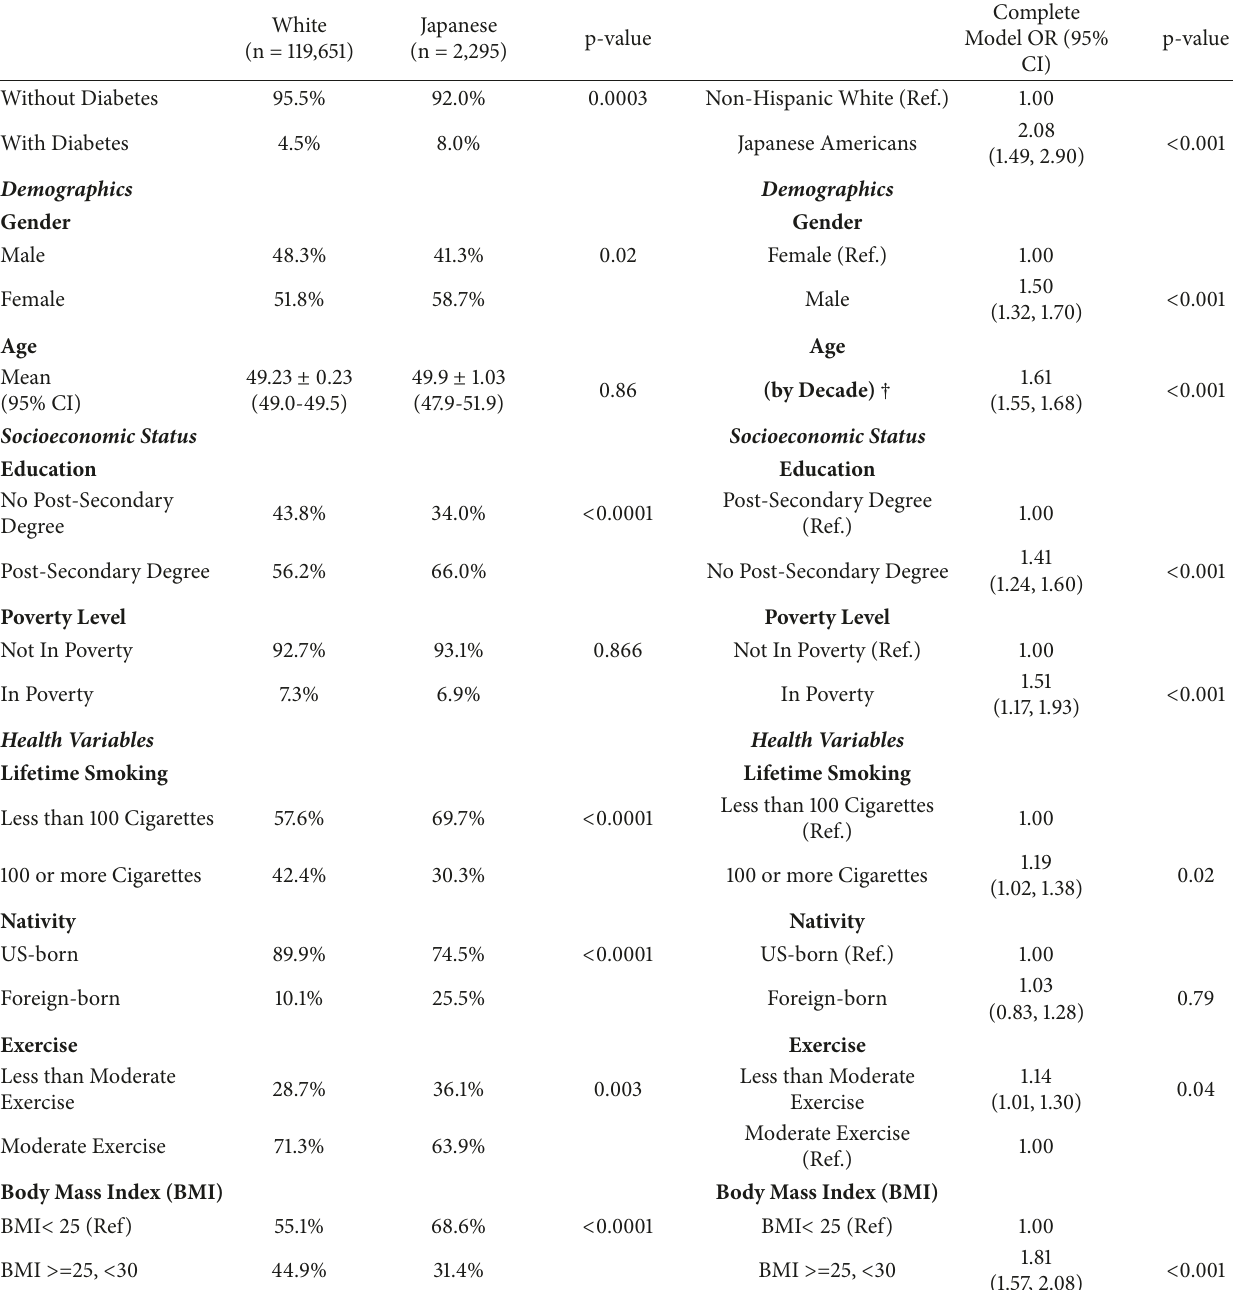
Table 1: Descriptive variables characteristics and odds of having diabetes (OR) of nonobese Japanese-American and non-Hispanic